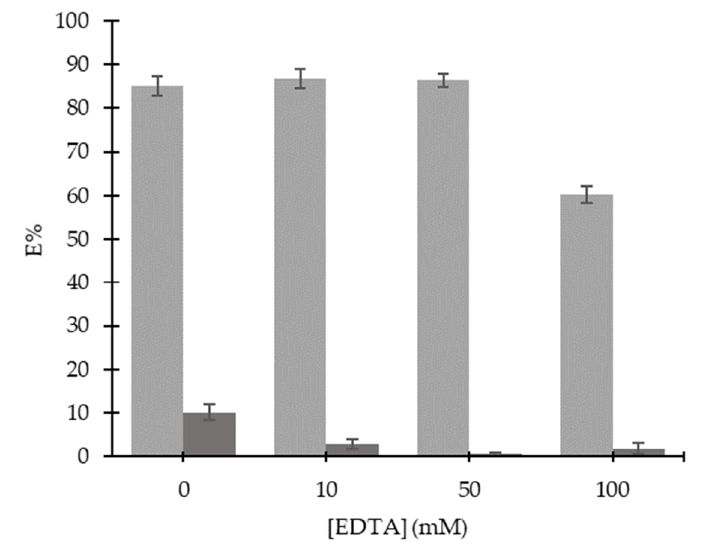
Figure 3. E ff ect of ethylenediaminetetraacetic acid (EDTA) on the extraction of Cd(II) and Cu(II) ions (Aliquat 336: 100 mM; TBP: 50 mM; diluent: toluene; mixing time: 10 min; operating temperature: 28 ± 1°C; mixing speed: 150 rpm; M i : 100 mg/L; pH eq : 5; O:A ratio = 1:1).